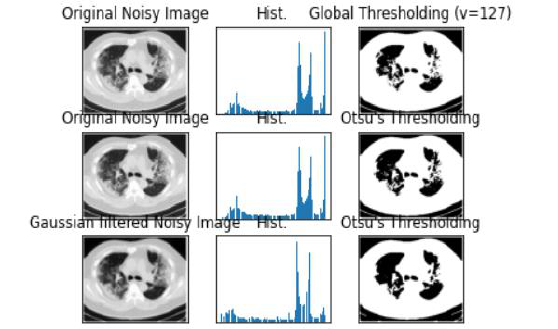
Figure 4.1: Otsu’s Thresholding Comparison with Global